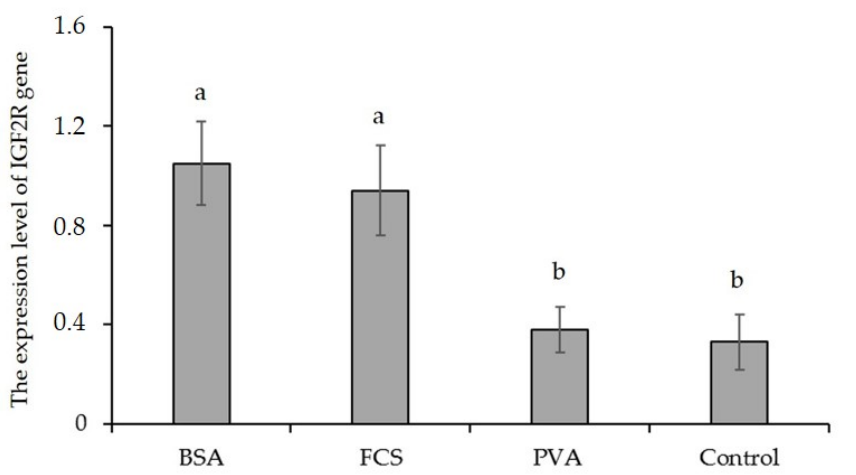
Figure 3. The expression level of the IGF2 gene in bovine oocytes matured in media supplemented with different macromolecules. BSA = bovine serum albumin, FCS = fetal calf serum, PVA = polyvinyl alcohol. The error bars represent the standard error of means, and bars with different letters are significantly different at p < 0.05.